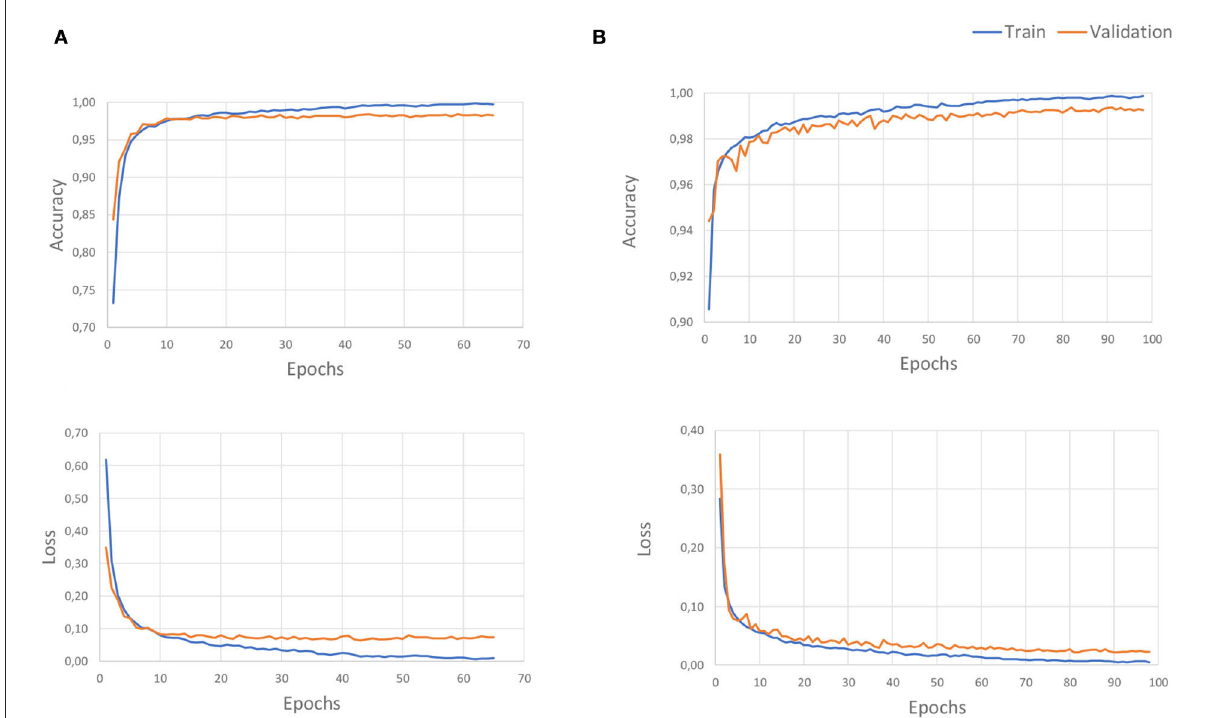
FIGURE8 The overage accuracy and the loss of recognition learning curves: The (A) for the LSTM model, and (B) for the CNN model. The values were scaled in the range between 0 and 1, with the accuracy of 1 indicating a perfect prediction, the loss gradually decreases over time, and it tends close to zero to express perfect learning from the features of the